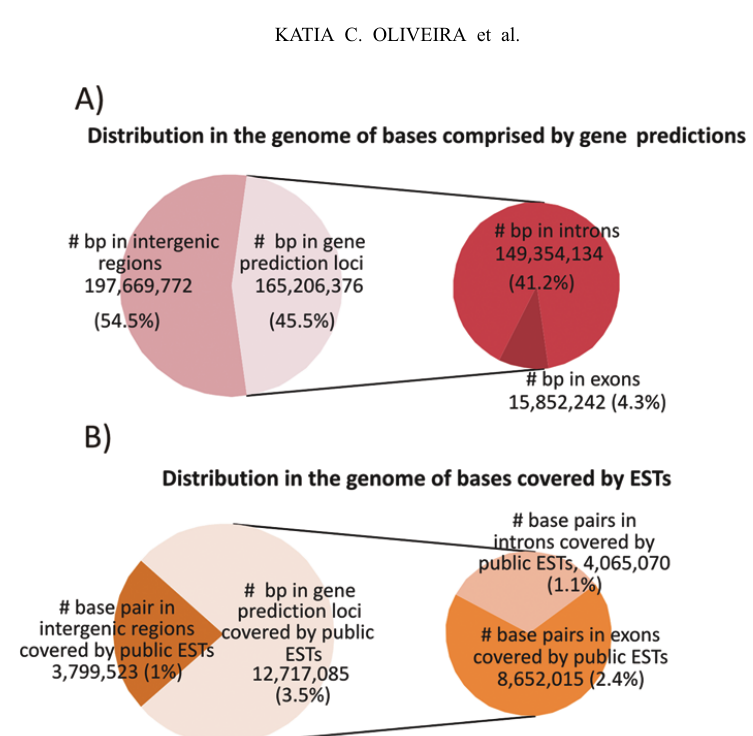
Fig. 3 – Analysis of S. mansoni genomic bases. A) Distribution of bases comprising gene predic- tions. B) Distribution of bases covered by public ESTs. Percentages on the right-hand part of each figure add up to the total percentage of the corresponding sub-category in the left-hand